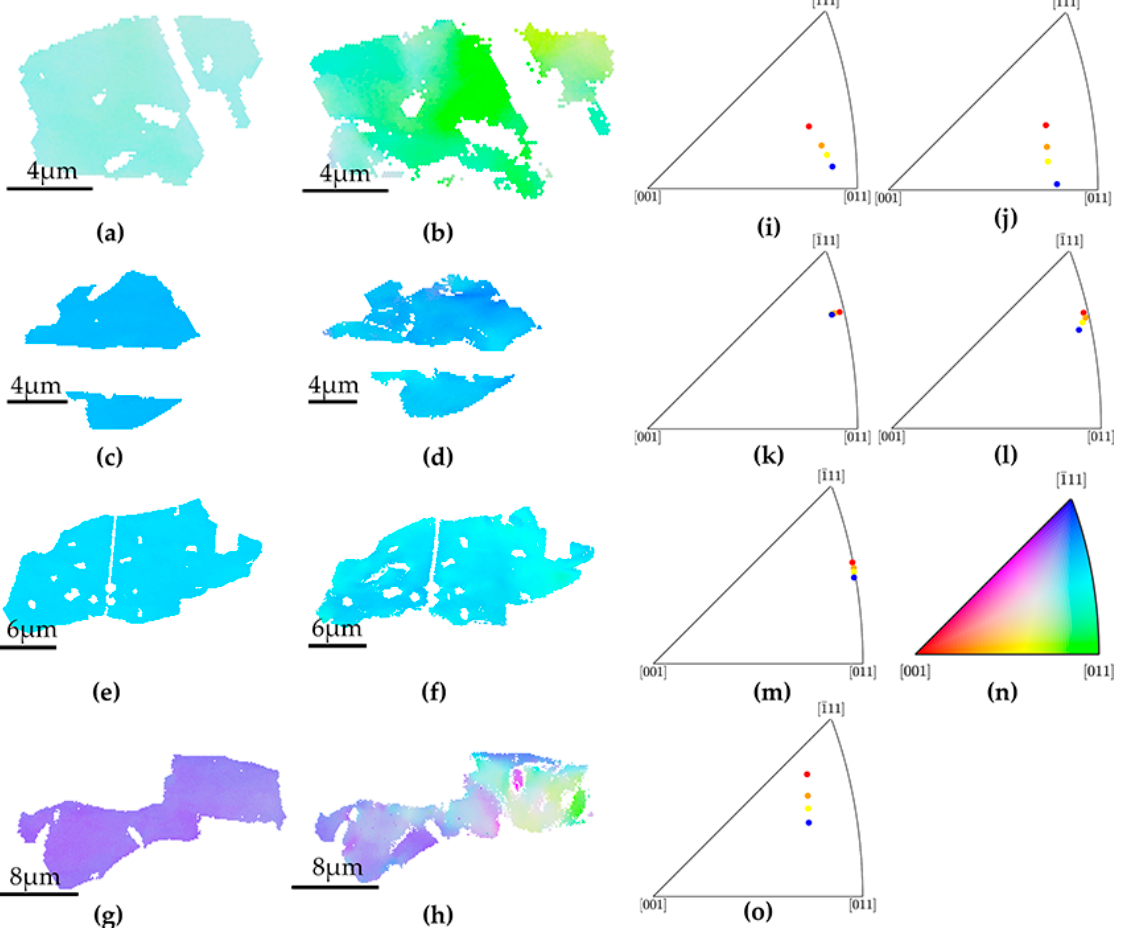
Figure 9. EBSD mapping of G1_1, G1_2 under strain ( a ) 0%, ( b ) 18%, G2_1, G2_2, under strain ( c ) 0%, ( d ) 18%, and G3, G4 under strain ( e , g ) 0%, ( f , h ) 18%. Mean orientation evolution in sequence of 0% (red), 12% (orange), 18% (yellow), 24% (blue), ( i ) G1_1, ( j ) G1_2 ( k ) G2_1, ( l ) G2_2, ( m ) G3 and ( o ) G4. ( n ) IPF color key.